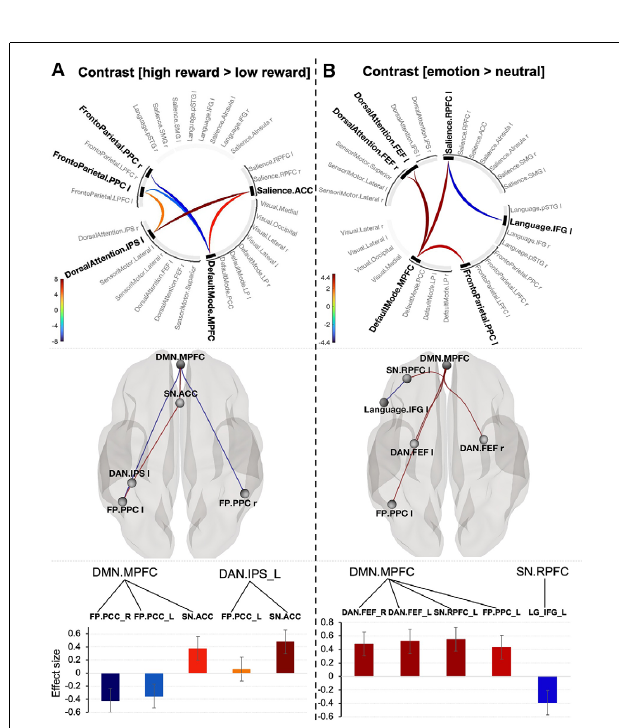
FIGURE 3 | Connectogram of networks (top row), corresponding glass brain (middle row) and effect sizes of individual connections within a cluster (low row) for value-based (A) and emotion (B) prioritization effects [the connectivity threshold p < 0.001, cluster threshold p-FWE corrected ( p < 0.05)]. Vertical color bars indicate T-test statistics for individual connections. Glass brain figures visualize spatial location of connections comprising each component where a sphere represents the center of the corresponding network. The red and blue lines depict positive or negative correlations between networks. Effect sizes: the Y axis represents Pearson correlation values where the sign indicates the direction of the effect. Error bars represent standard deviations. The color of the effect size bars corresponds to the color of relevant connections in the